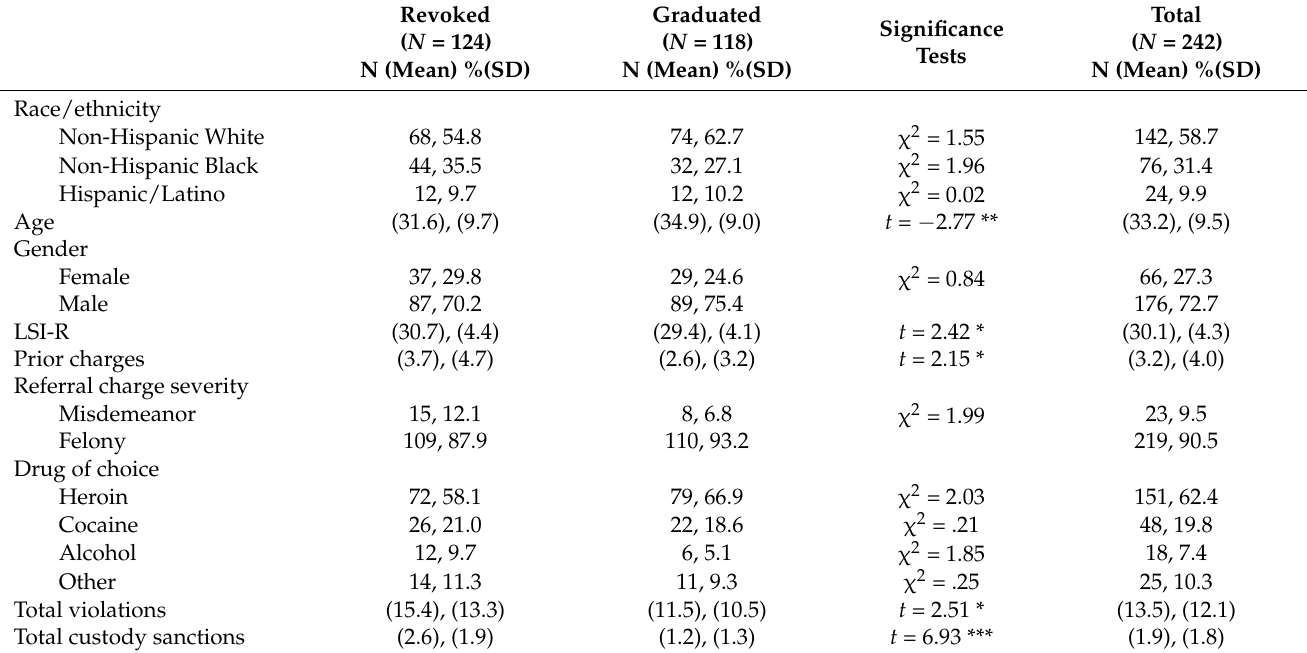
Table 4. Descriptive Statistics for Likelihood of Graduation ( N =